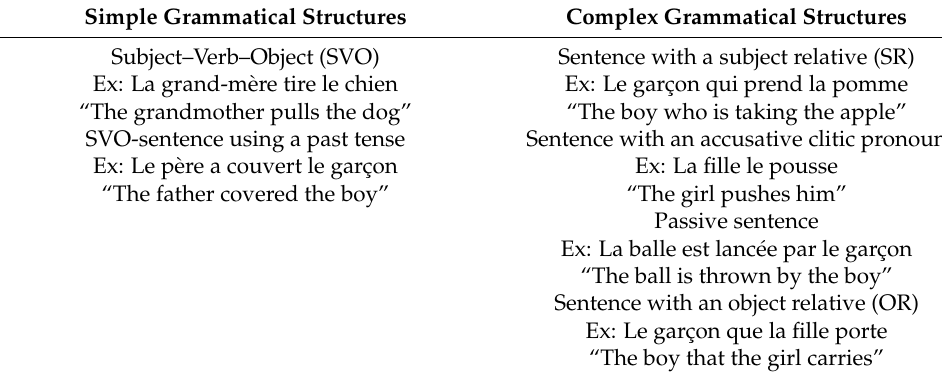
Table 2. Target grammatical